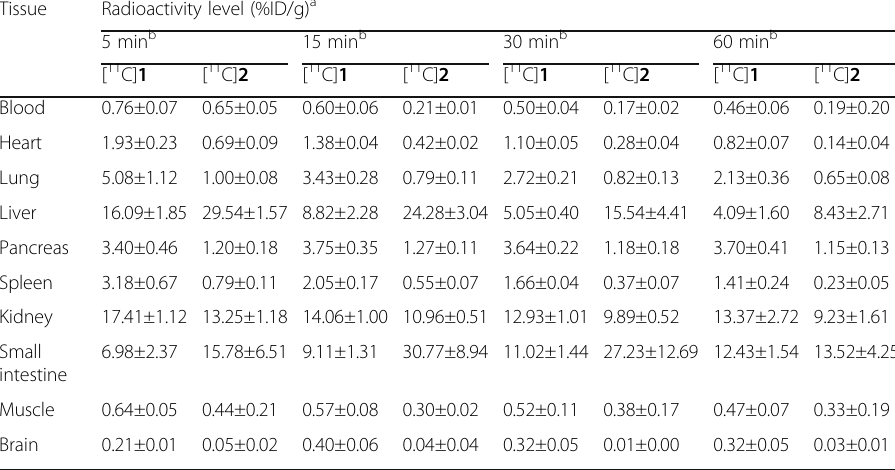
a Mean±S.D. (n=4) b Time elapsed after the injection of 11 C-labeled